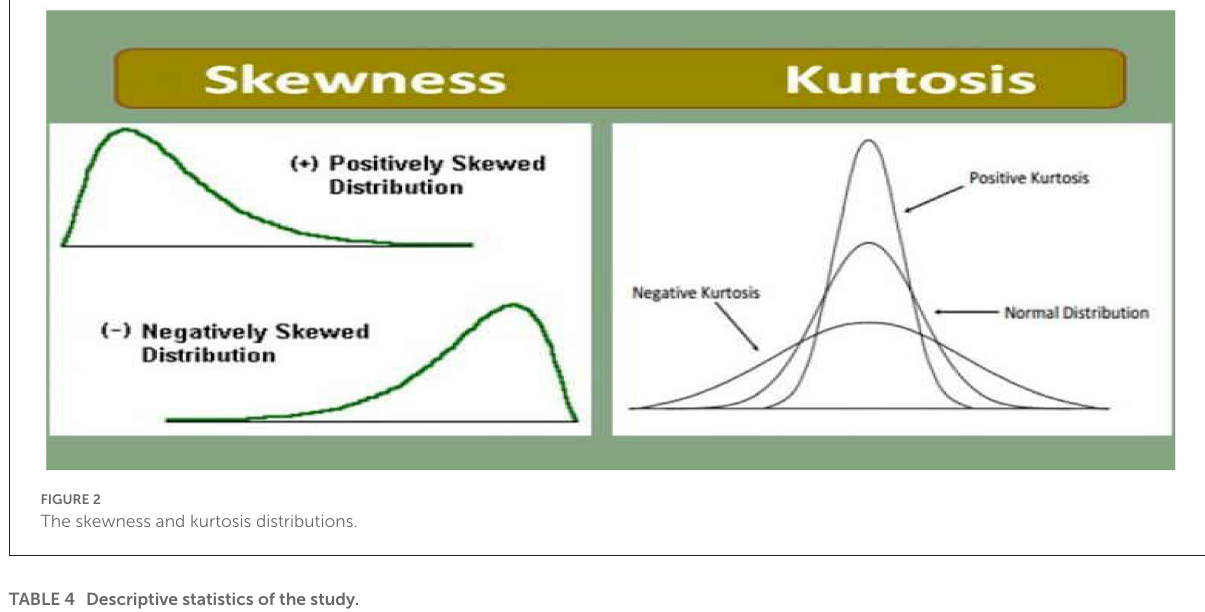
TABLE 4 Descriptive statistics of the